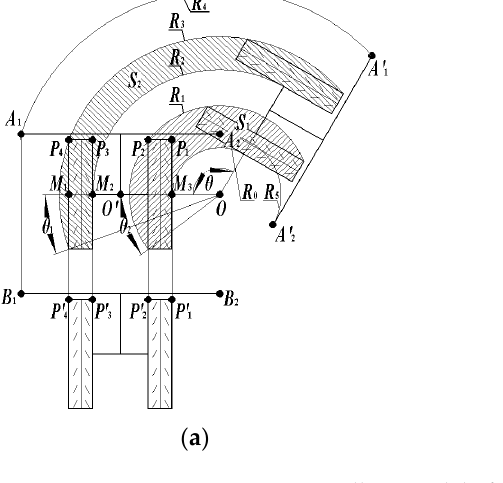
Figure 8. Rolling model of ratoon rice in the first season. ( a ) Straight and turning rolling model of full crawler harvester; ( b ) field walking model of the harvester.